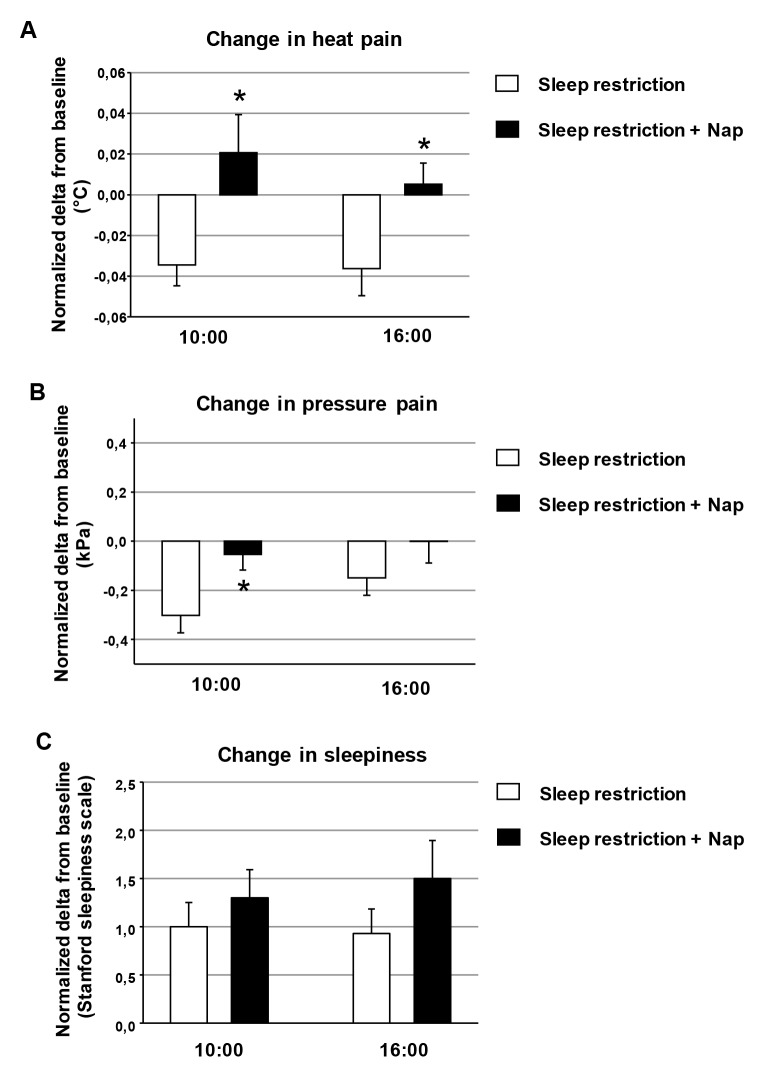
Changes in heat pain, pressure pain and sleepiness without or with napping after sleep restriction.We assessed the effects of napping, by comparing the different sleep restriction conditions (“sleep restriction” session and “sleep restriction + nap” session), using normalized delta scores for each sleep restriction condition relative to the corresponding baseline. Changes are shown for heat pain (A), pressure pain (B) and sleepiness (C). Sleep restriction increased sleepiness and decreased pain tolerance, whereas napping reversed the increase in pain sensitivity but did not decrease sleepiness (due to sleep inertia). Mean ± SEM; * indicates significant differences between conditions.